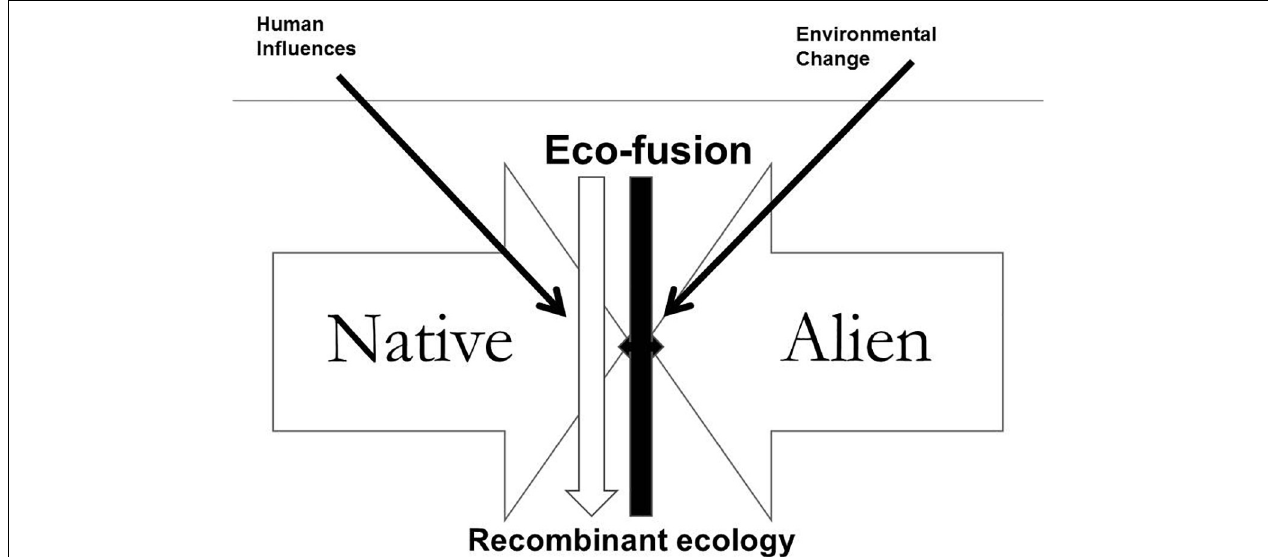
FIGURE 12 | Eco-fusion processes along the River Don (from Rotherham,